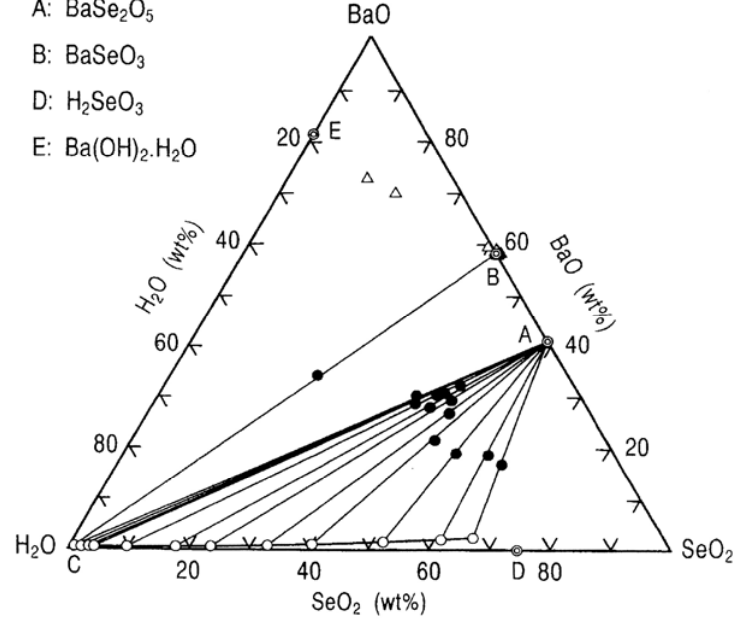
-H O system at 25 2 2